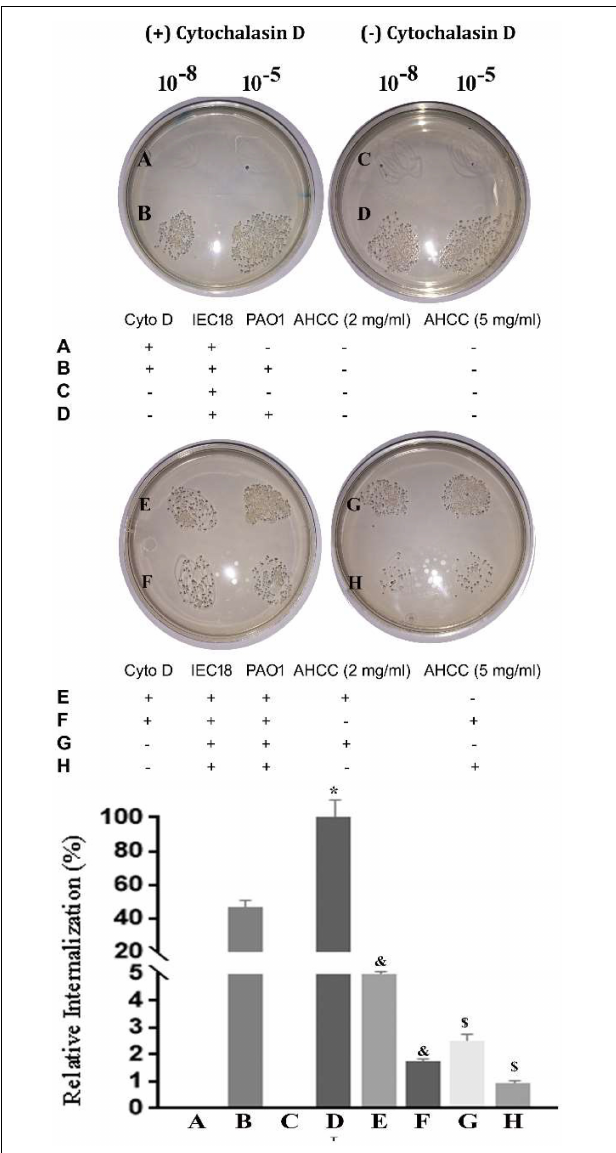
FIGURE 7 | Effect of AHCC R (cid:13) on internalization by IEC 18 in vitro. In the presence and in the absence of 8 µ M Cyto D, the cells were synchronously infected with 10 CFU/cell for 60 min. Bacterial internalization was analyzed by automatically quantifying the growth colony forming units (CFU) (The experiment are performed in triplicated; mean ± S.E.M). The graph shows the mean percentage of bacterial internalization with respect to the sample control in the presence or absence of 20 mg/mL AHCC R (cid:13) . * p < 0.05 vs. without Cyto D and & p < 0.05 vs. without AHCC R (cid:13) (ANOVA followed by least significance